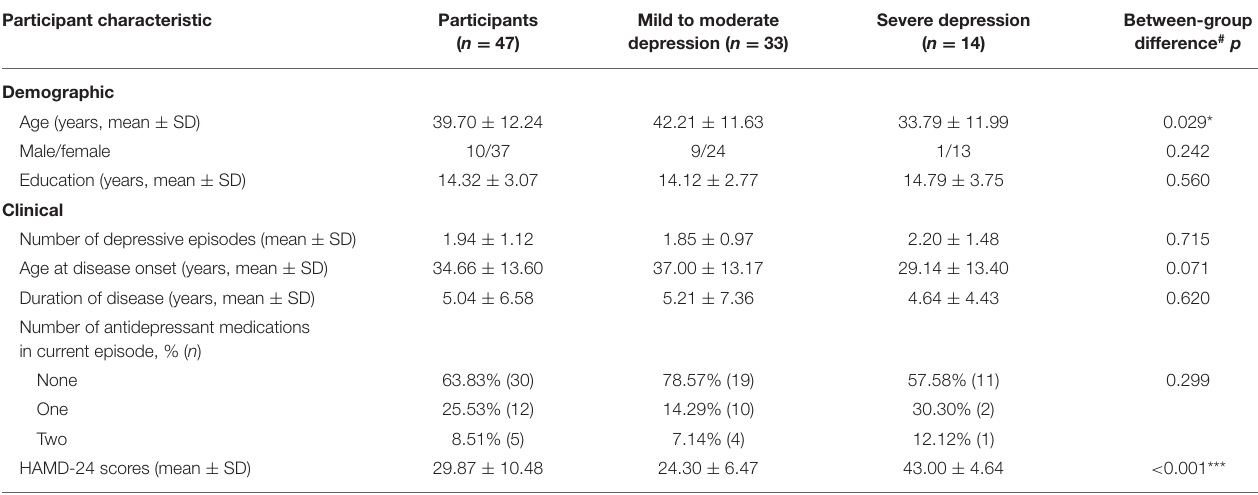
TABLE 1 | Demographic and clinical characteristics of included participants.